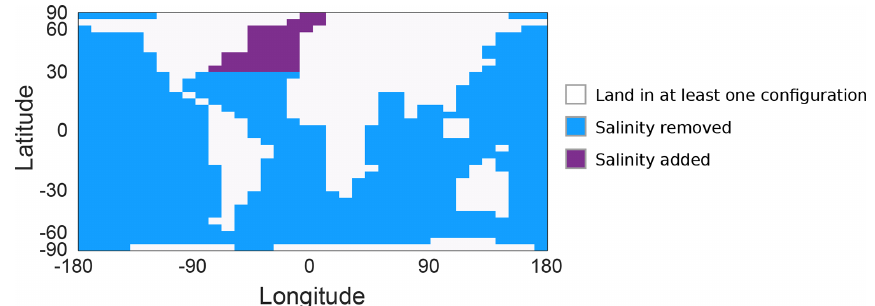
Figure B3. Location of salinity addition and salinity removal common to all configurations for the salinity flux adjustment controller “FwF”.